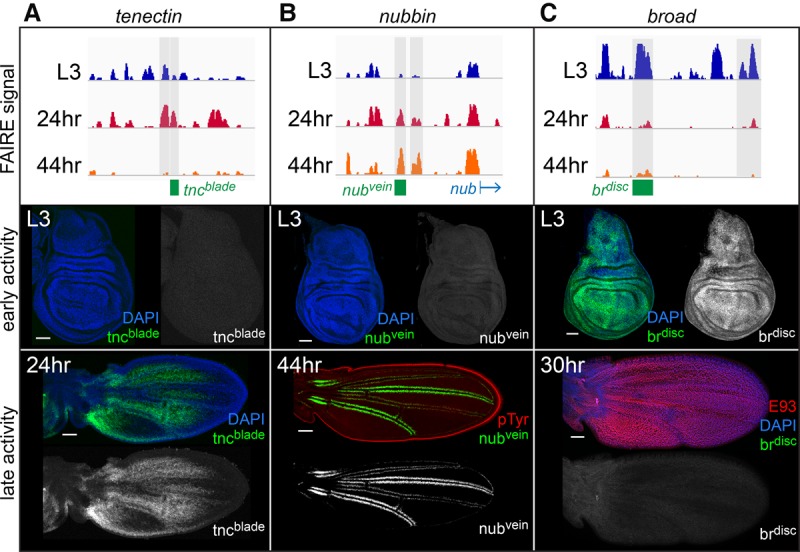
Temporally dynamic open chromatin corresponds to temporal-specific enhancer activity. (Top row) Browser shots of FAIRE-seq signal from the tnc (A), nub (B), and broad (C) loci, with cloned regions indicated by gray boxes, and depicted enhancers indicated by green boxes. (Middle and bottom rows) Immunostaining of reporter activity in wings at the indicated early and late time points. Enhancer activity is in green. Bars, 50 µm. Additional time points are shown in Supplemental Figure S3.